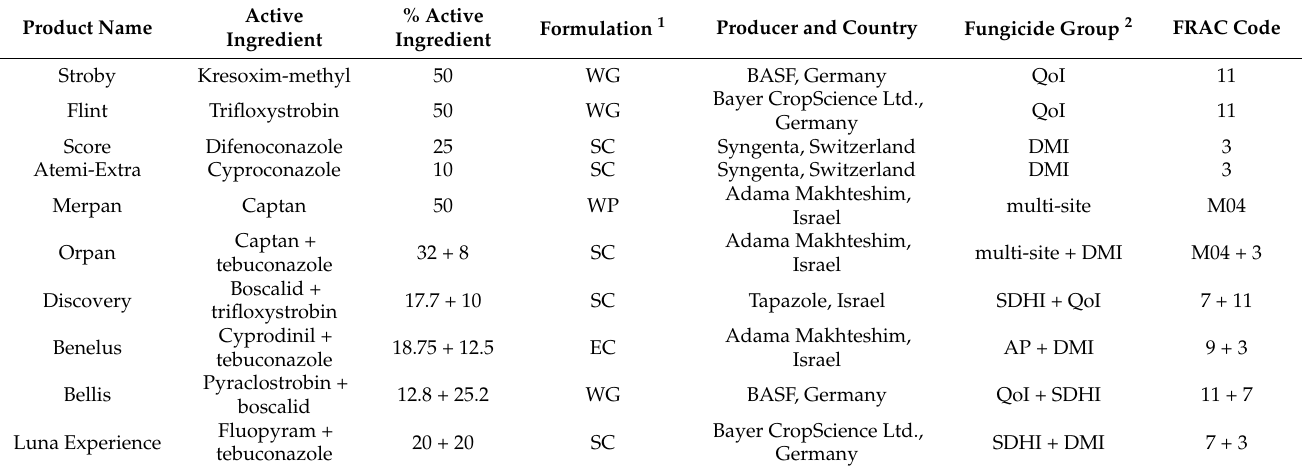
Table 1. List of the fungicides used in the laboratory experiments and the field